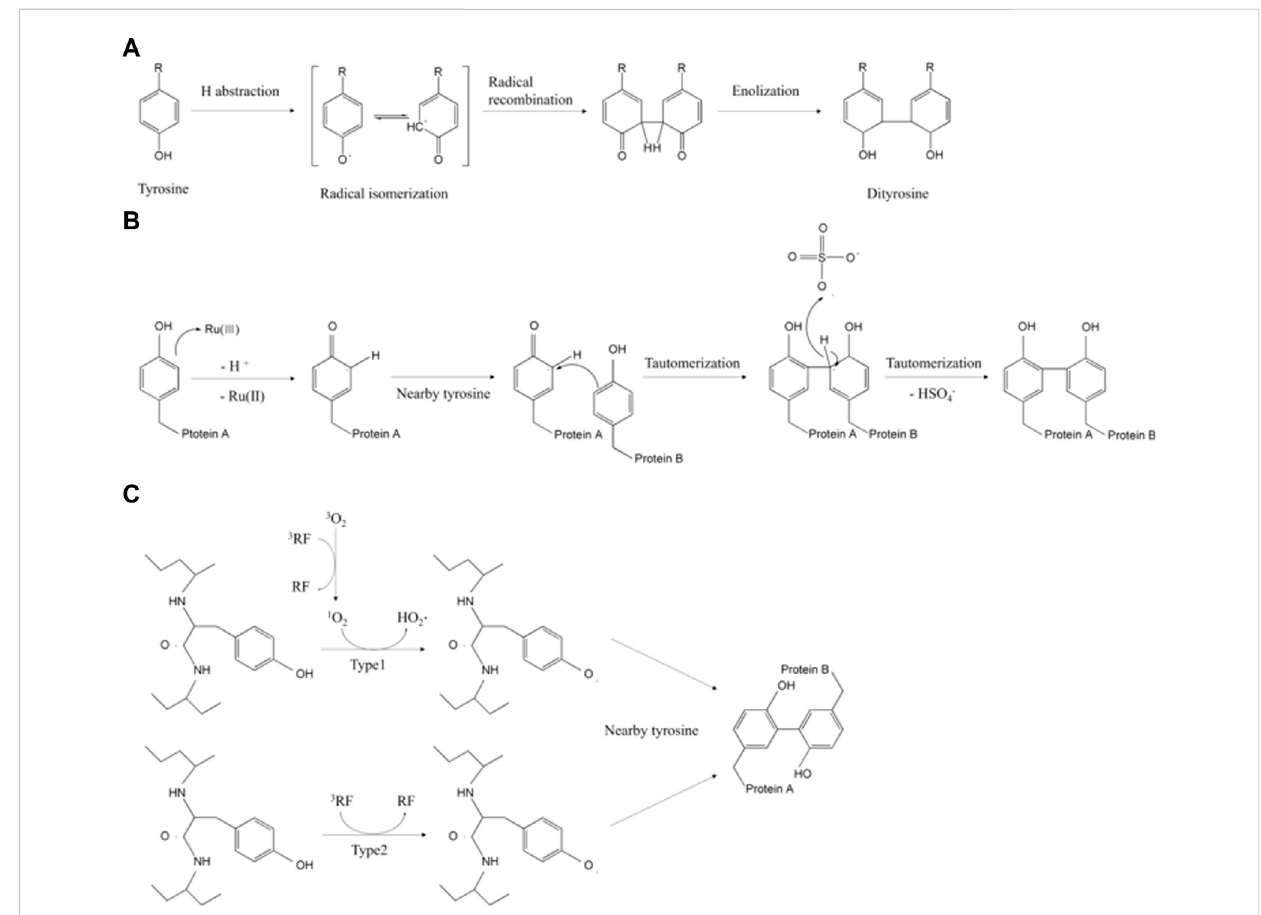
FIGURE 1 Overview oftyrosylresiduecrosslinking mechanisms initiated by (A) UVlight(Correia etal.,2012), (B) Ru( Ⅱ )polypyridine (Fancyand Kodadek, 1999), and (C) ribo fl avin (Liu et al.,